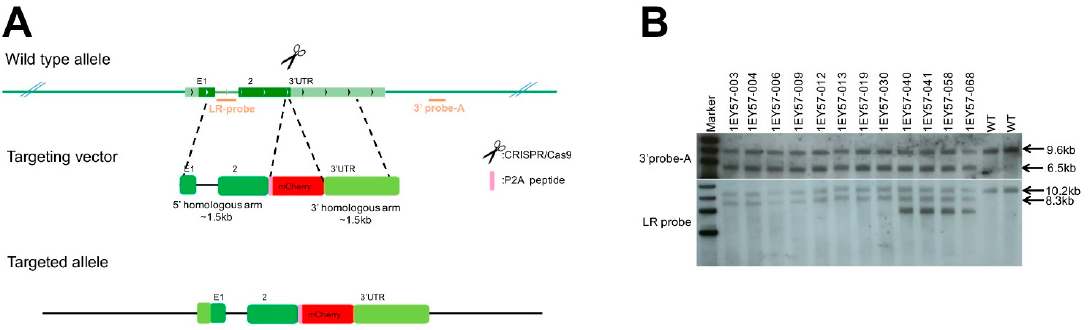
Figure 1. Design and validation of CRISPR/Cas9 strategy. ( A ) Schematic of the mouse Brn3b locus. The dark green boxes correspond to the two exons of Brn3b (E1/2). Two probes named LR-probe and 3 ′ probe-A (orange lines) were used to identify correctly targeted animals. ( B ) Southern blot of Brn3b-mCherry mice showing correct insertion of the mCherry targeting vector into the Brn3b locus. Further details on Southern blot design strategy design is detailed in Figure S1.